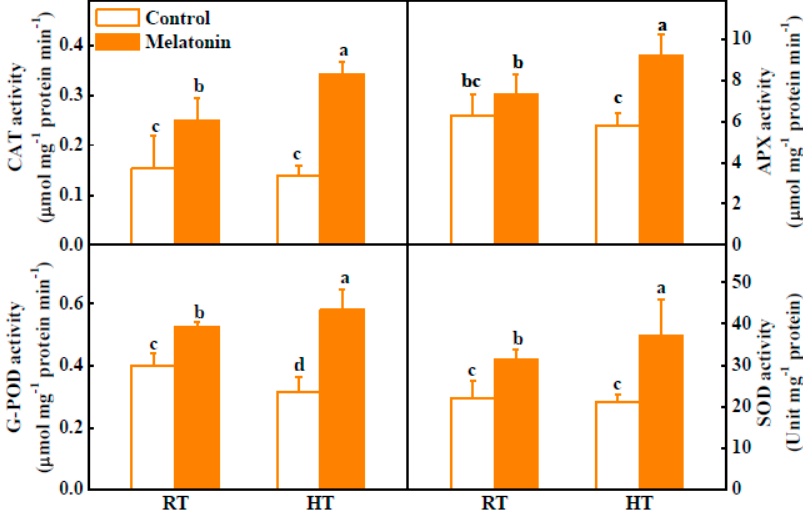
Figure 4. Activities of CAT, APX, G-POD and SOD in tomato anthers after 3 h high temperature stress. The data shown are the average of four replicates, with the standard errors shown by vertical bars. Means denoted by the same letter did not significantly differ at p < 0.05, according to Tukey’s test.